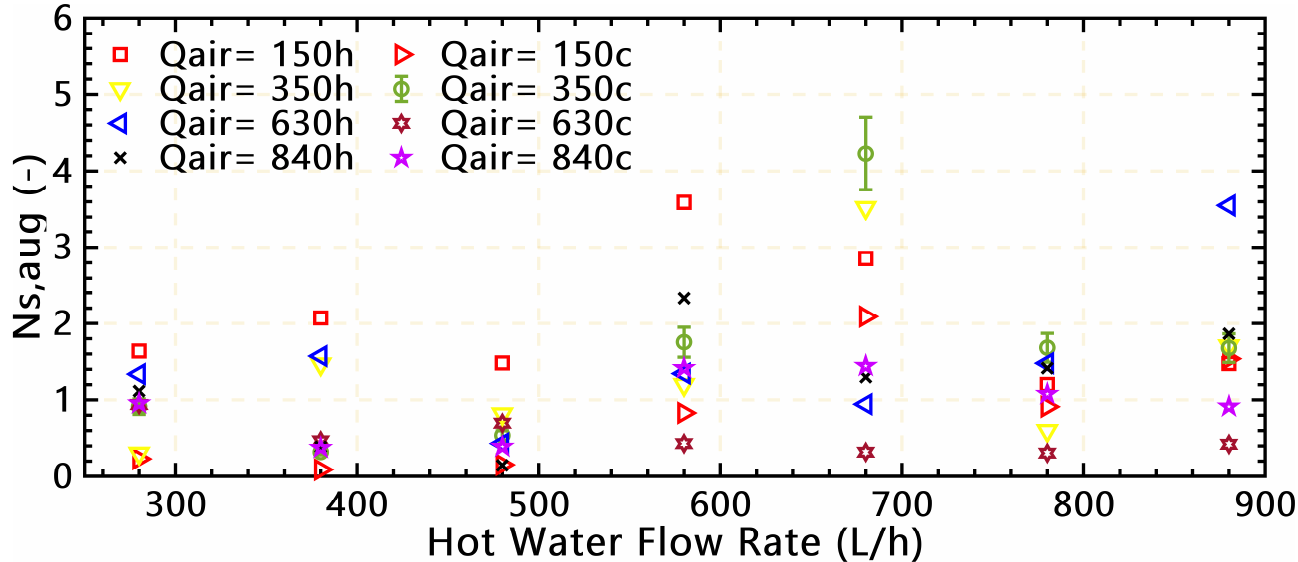
Figure 10. 𝑁 (cid:3046),(cid:3028)(cid:3048)(cid:3034) vs. 𝑄 (cid:3035) at different ABI into both CWS and HWS. Figure 10. N s , aug vs. Q h at different ABI into both CWS and HWS.